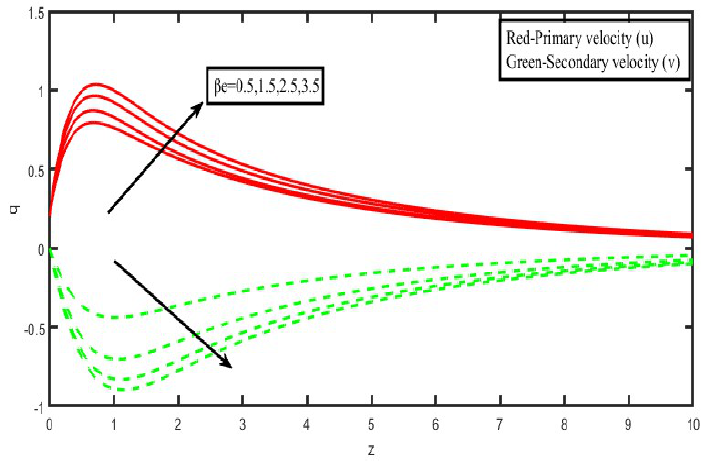
Figure 6. Velocity profiles for u and v for Hall parameter (β e ).